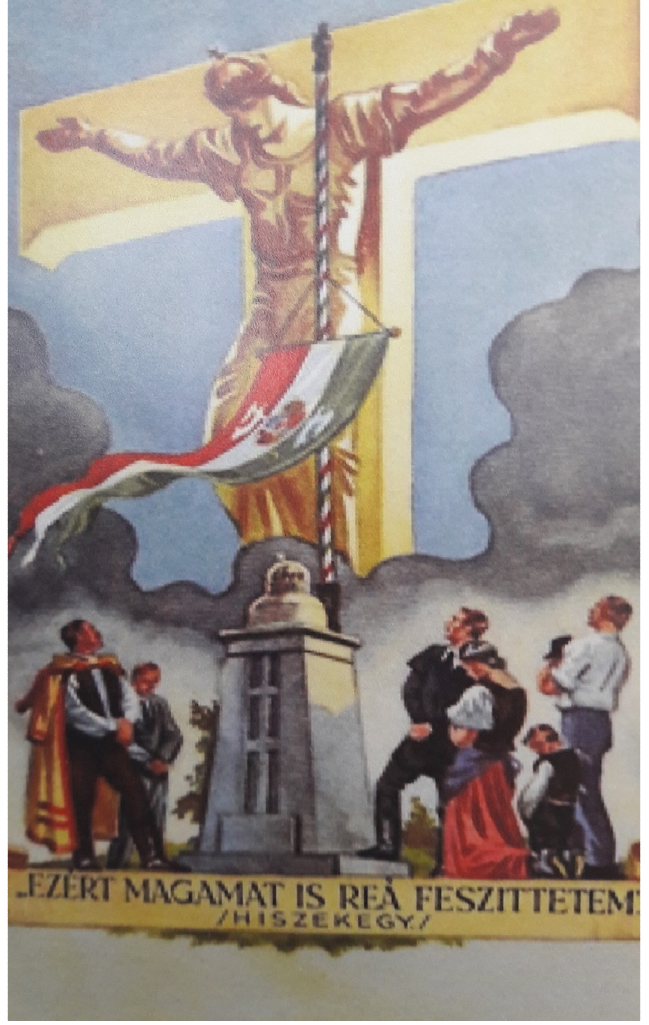
Figure 3. A postcard quoting the Hungarian Creed: “I have myself crucified on it”. The female figure on the cross wears the “Holy Crown”, a symbol of Hungarian statehood since the Middle Ages, while the T-shaped cross refers to the Treaty of Trianon. From the Trianon exhibition of the Calvinist Church in Pócsmegyer, 2020.